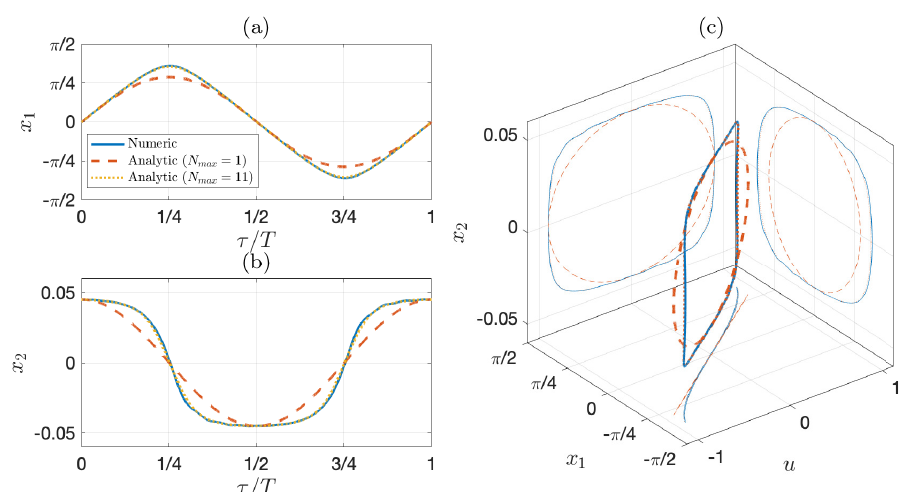
Figure 4. Comparison of the pendulum behavior predictions using the numeric and analytic solution (60) and (61) ( N max = 11) for η = 0.1428, n = 0, ω = 0.05, A = 0.9 and φ = 0 ( T = 2 π / ω ). ( a ) x 1 vs. τ / T , ( b ) x 2 vs. τ / T , and ( c ) phase plane ( x 1 , x 2 , u )